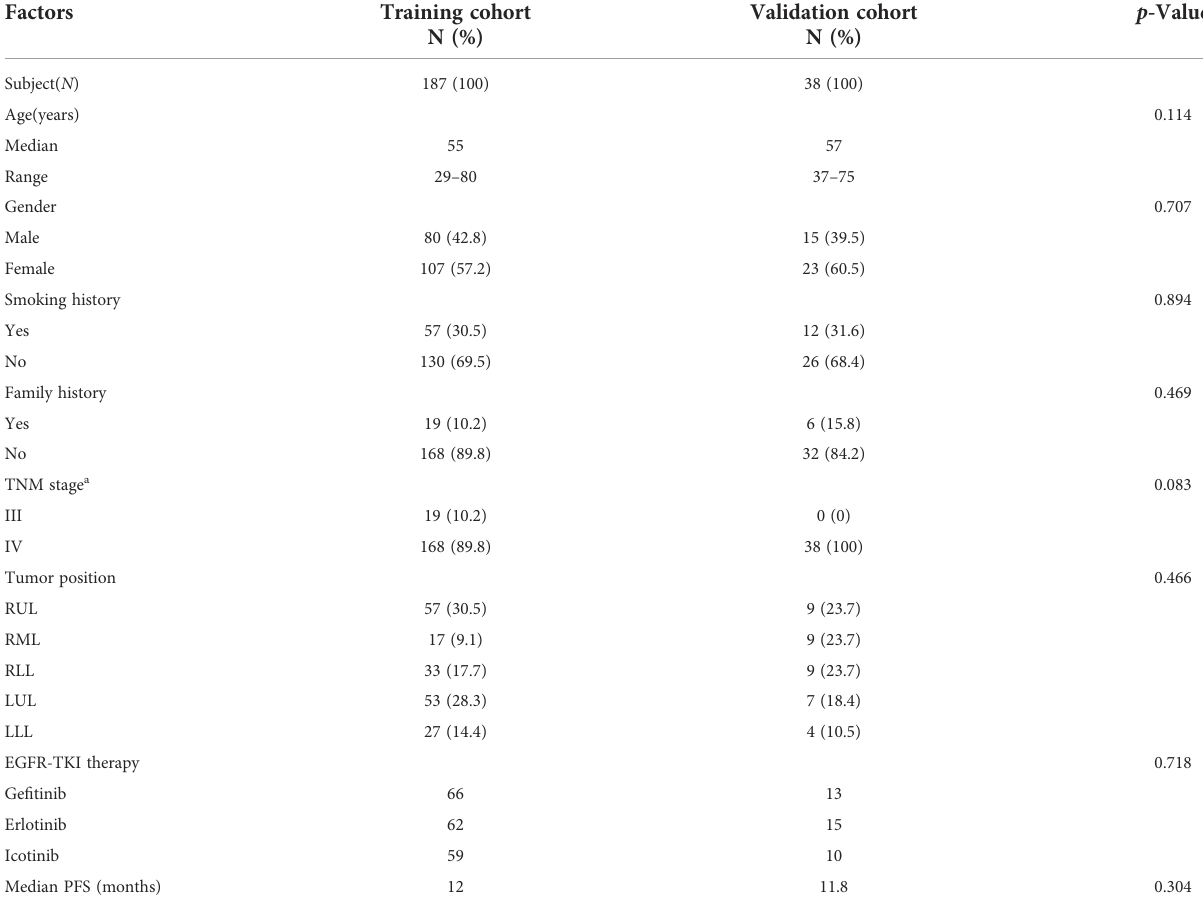
TABLE 2 Clinical characteristics of patients included in treatment response analysis.